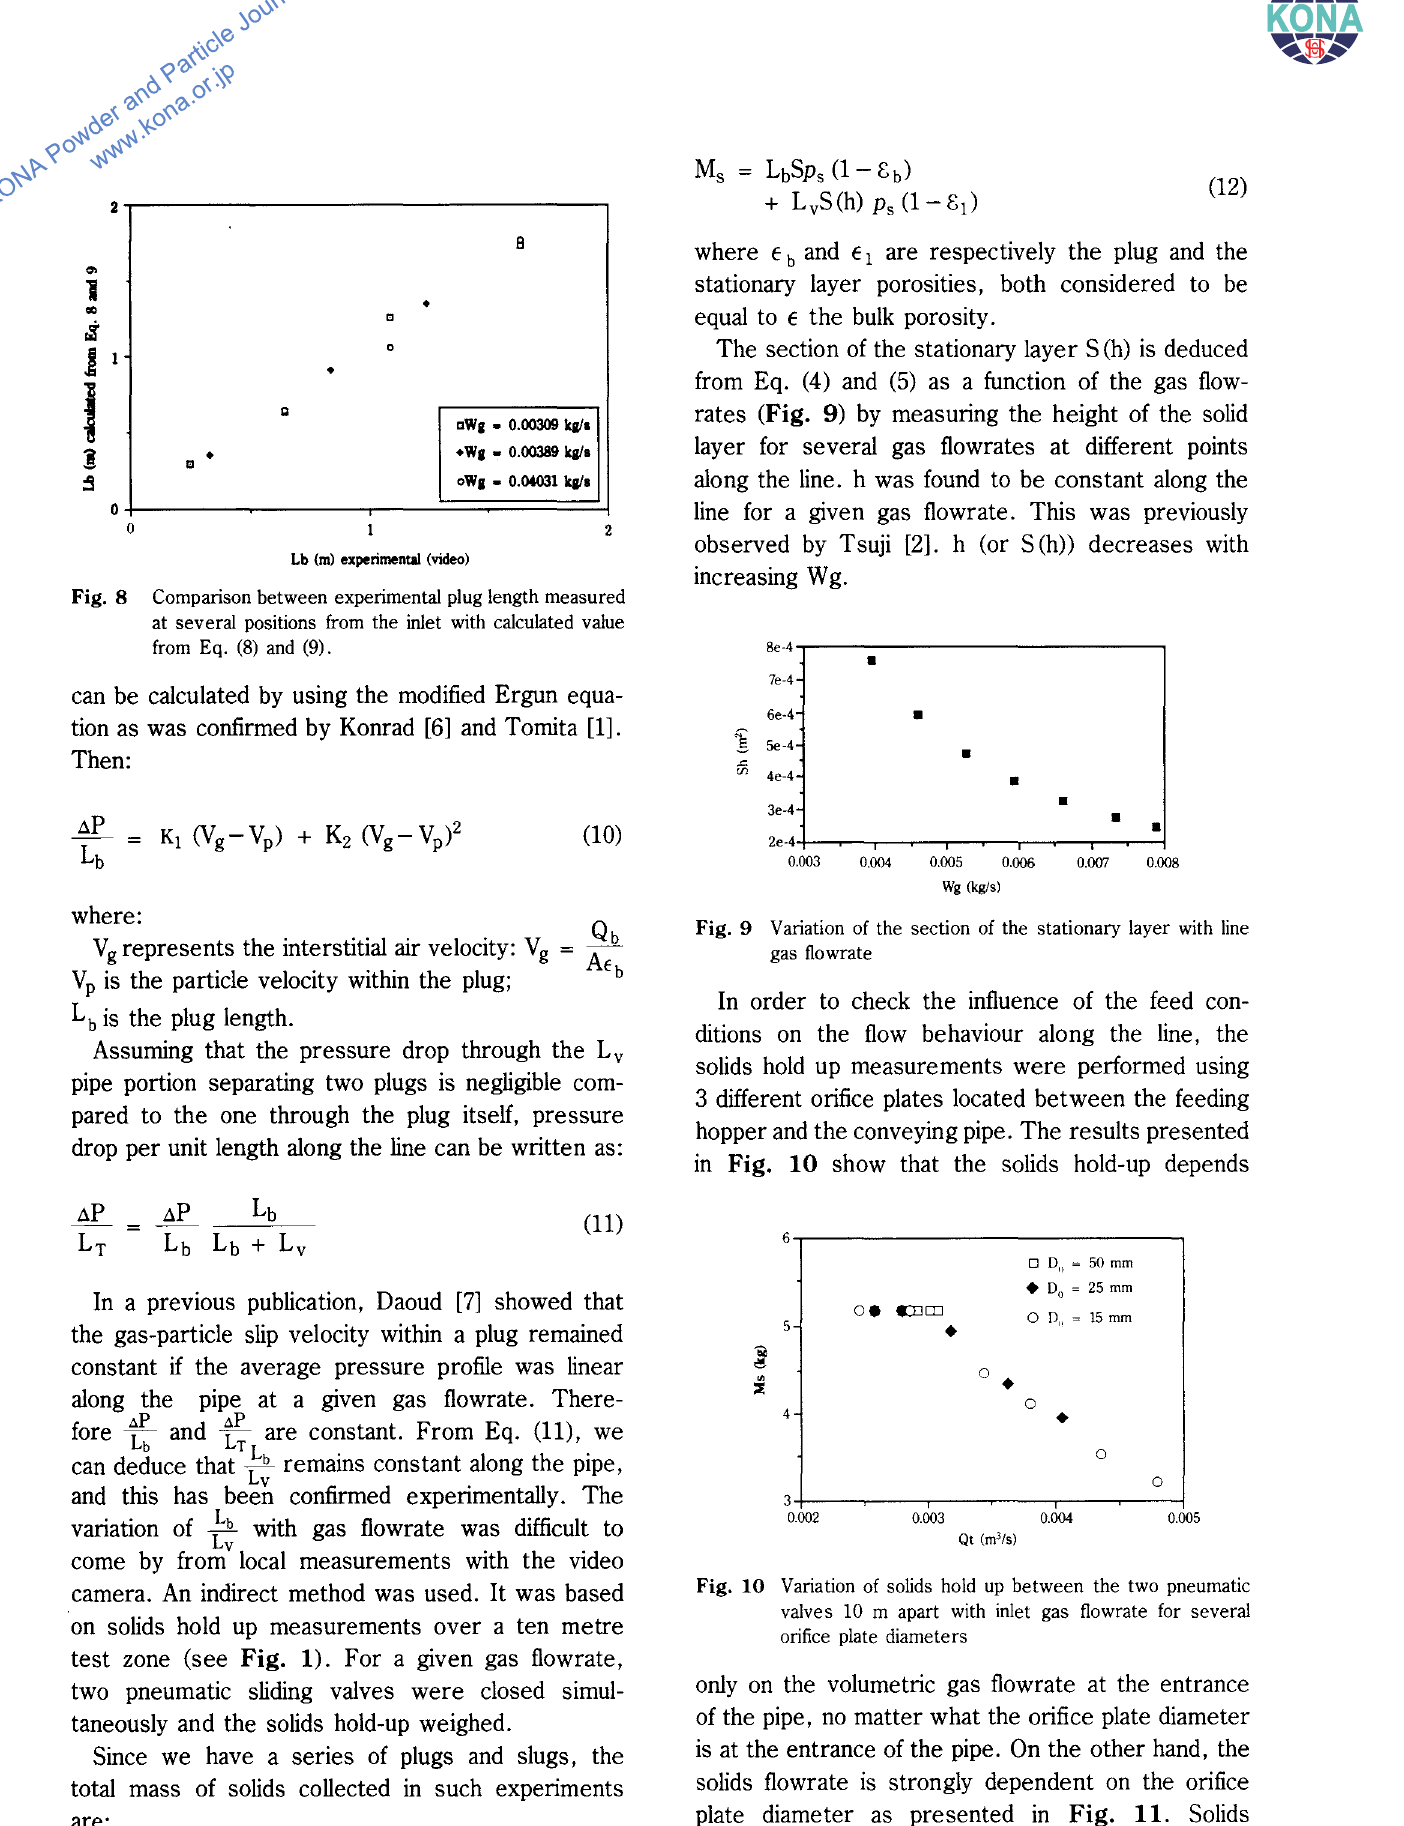
where E b and E are respectively the plug and the 1 stationary layer porosities, both considered to be equal to E the bulk porosity. The section of the stationary layer S (h) is deduced from Eq. (4) and (5) as a function of the gas flow rates (Fig. 9) by measuring the height of the solid layer for several gas flowrates at different points along the line. h was found to be constant along the line for a given gas flowrate. This was previously observed by Tsuji [2]. h (or S (h)) decreases with increasing W g.